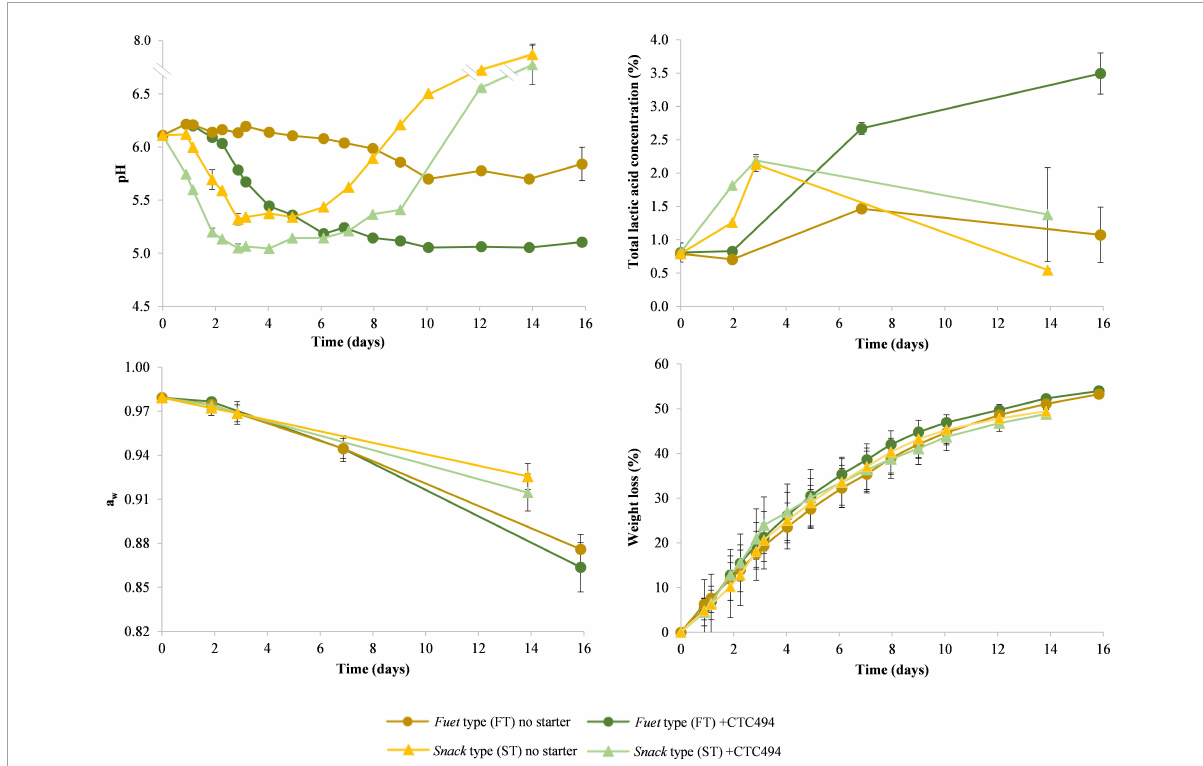
FIGURE2 Results of physico-chemical determinations (pH, total lactic acid concentration, a w and weight loss) during the fermentation and ripening of fuet -type (FT) and snack-type (ST) sausages spontaneously fermented (no starter) and with the addition of the bioprotective